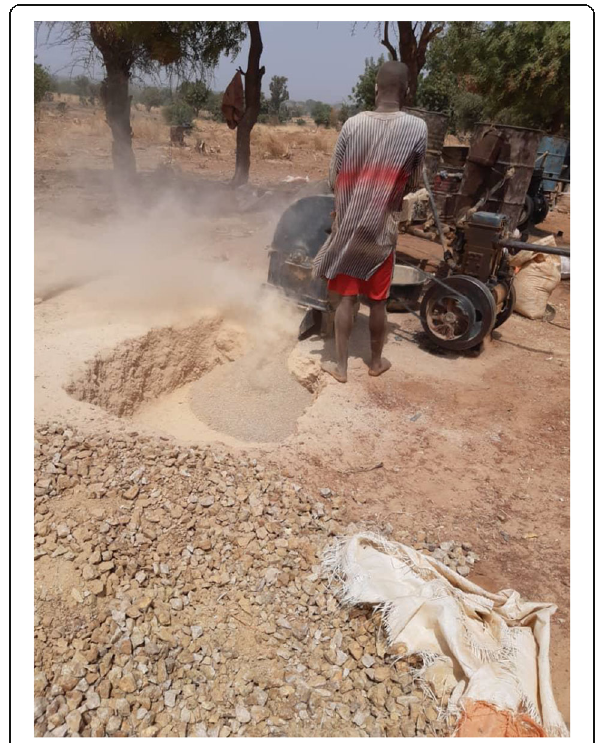
Fig. 2 Site 1 of the local mining area